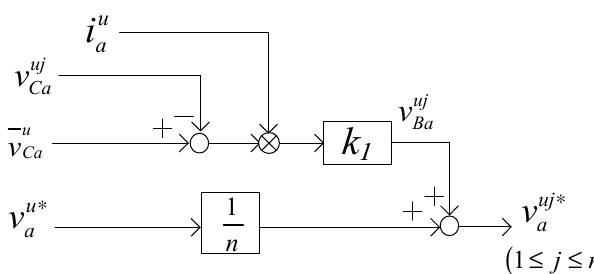
Figure 11. Block diagram of the individual capacitor voltage balancing of branch-au.